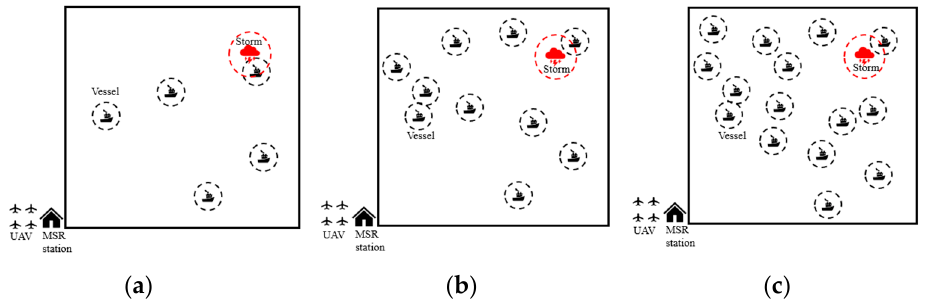
Figure 8. Three MSR task scenarios. ( a ) Scenario 1. ( b ) Scenario 2. ( c ) Scenario 3. Table 1. Parameter settings of three compared algorithms.